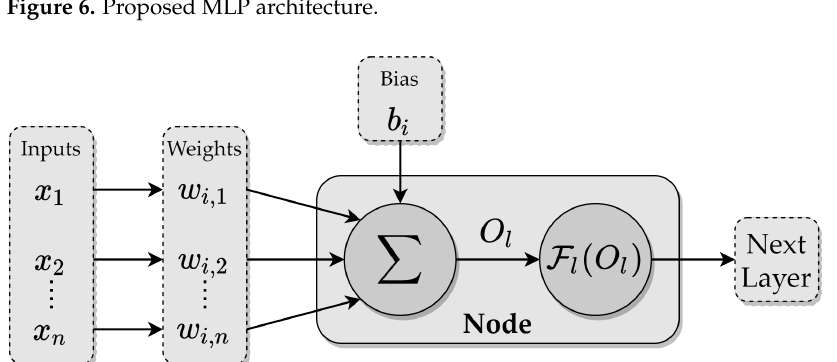
Figure 7. Data processing in a neural network